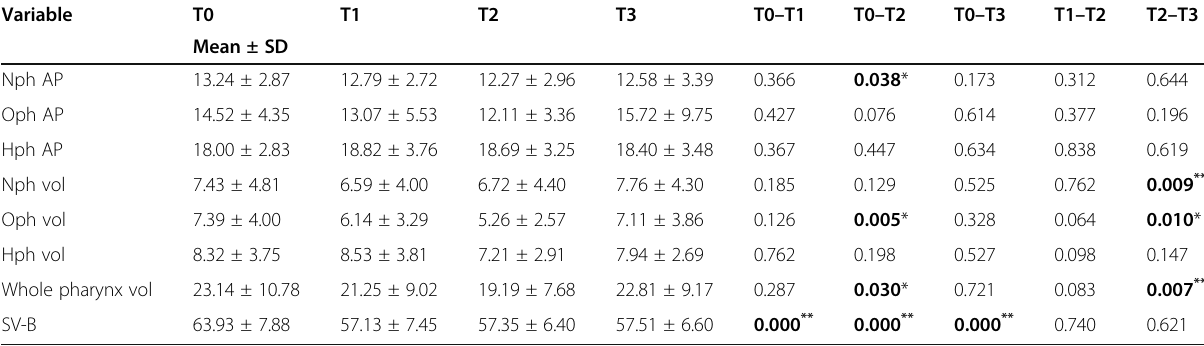
Table 5 Measurements and comparison of the pharyngeal airway in group 2 (BSSRO + Le Fort I osteotomy)